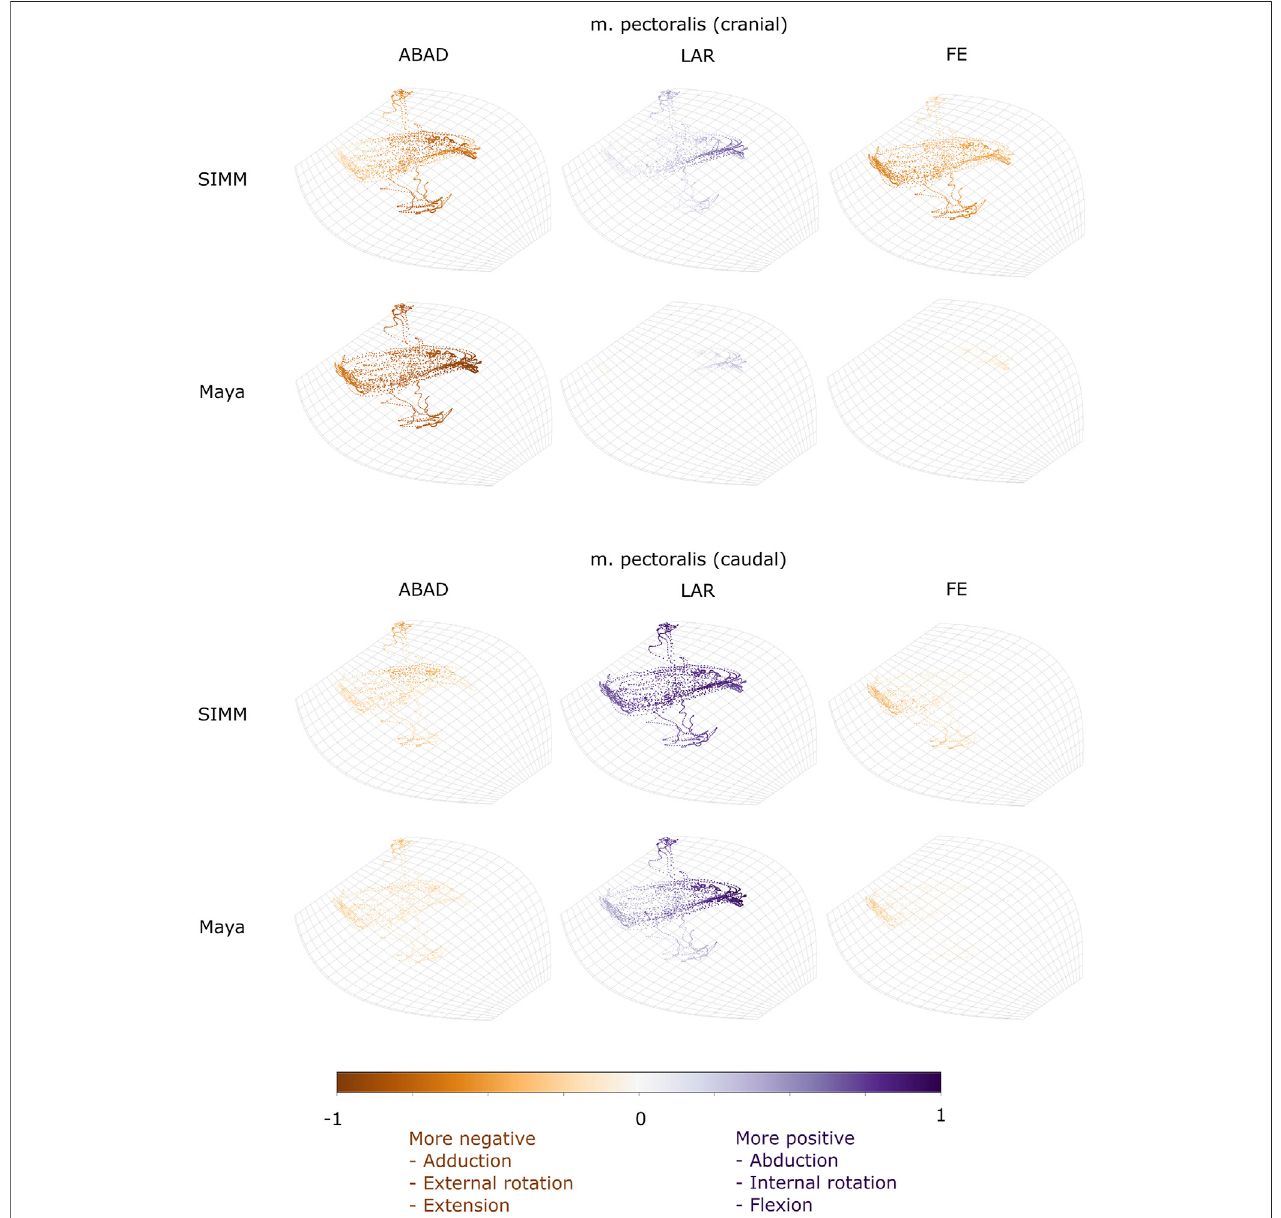
FIGURE 6 | Three-dimensional (3D) MMAs of m. pectoralis at the glenohumeral joint, plotted in cosine-corrected ROM space for the SIMM model (using partial velocity) and Maya experimental data (using the geometric method). MMA sign is indicated by point colour (positive values are purple, negative values are orange) with colour intensity scaled to relative MMA magnitude as described in the Methods. ABAD (cid:3) abduction-adduction; LAR (cid:3) long-axis rotation (internal-external rotation); FE (cid:3) fl exion-extension.